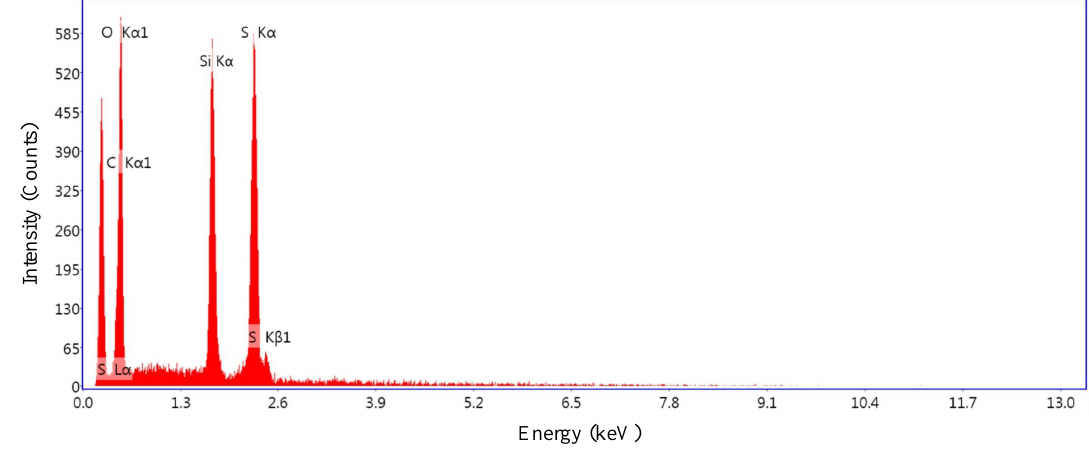
Figure 17. EDAX spectrum of the analysed